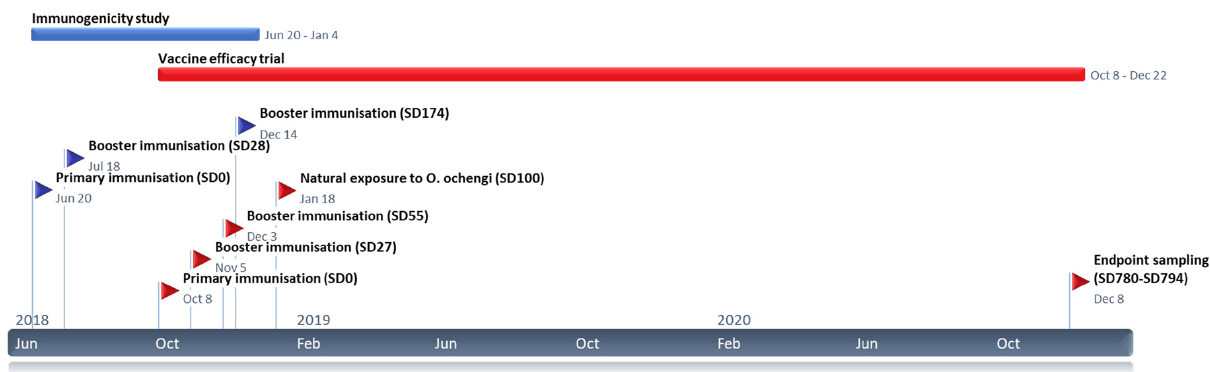
Figure 1. Timeline of critical events and durations of the vaccine immunogenicity study ( blue ) and vaccine efficacy trial ( red